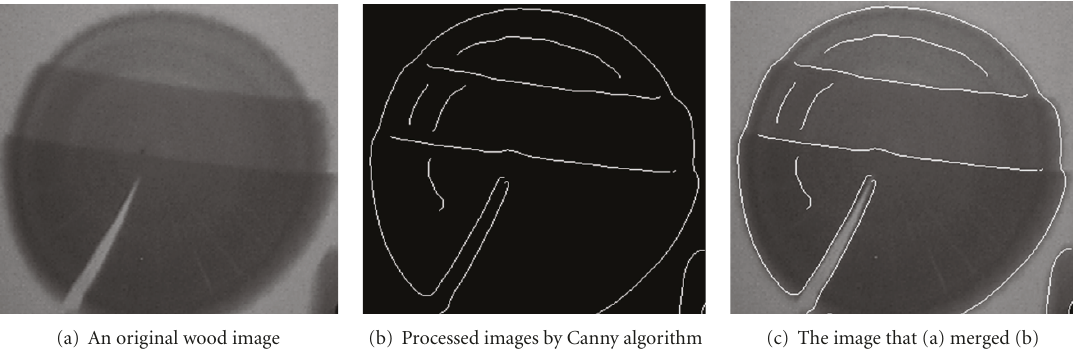
Figure 4: An original wood image and processed wood